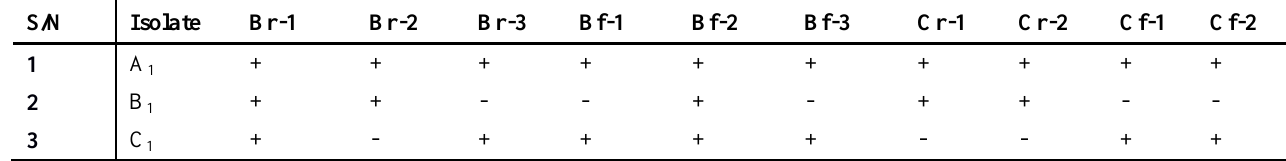
Table 4 . Morphology of the bacterial isolates in meat samples (beef and Chicken).